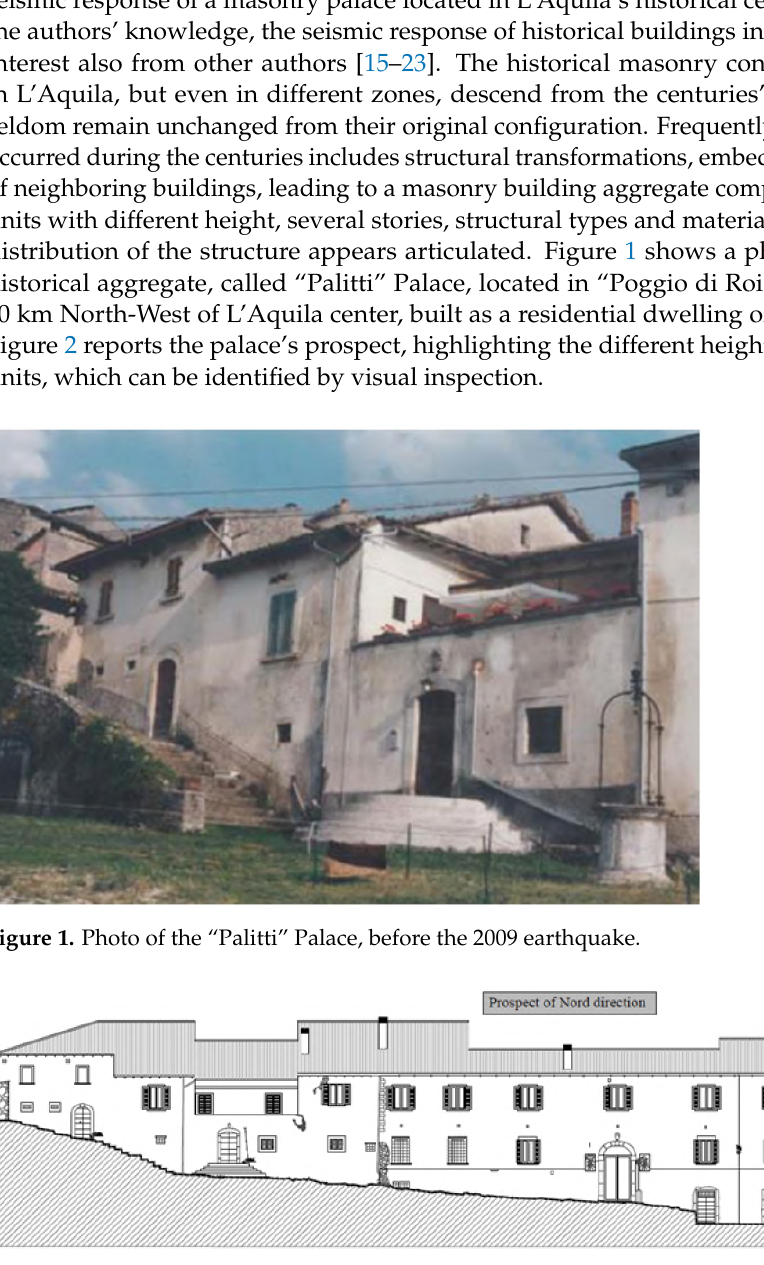
Figure 2. Prospect of the north direction of “Palitti”